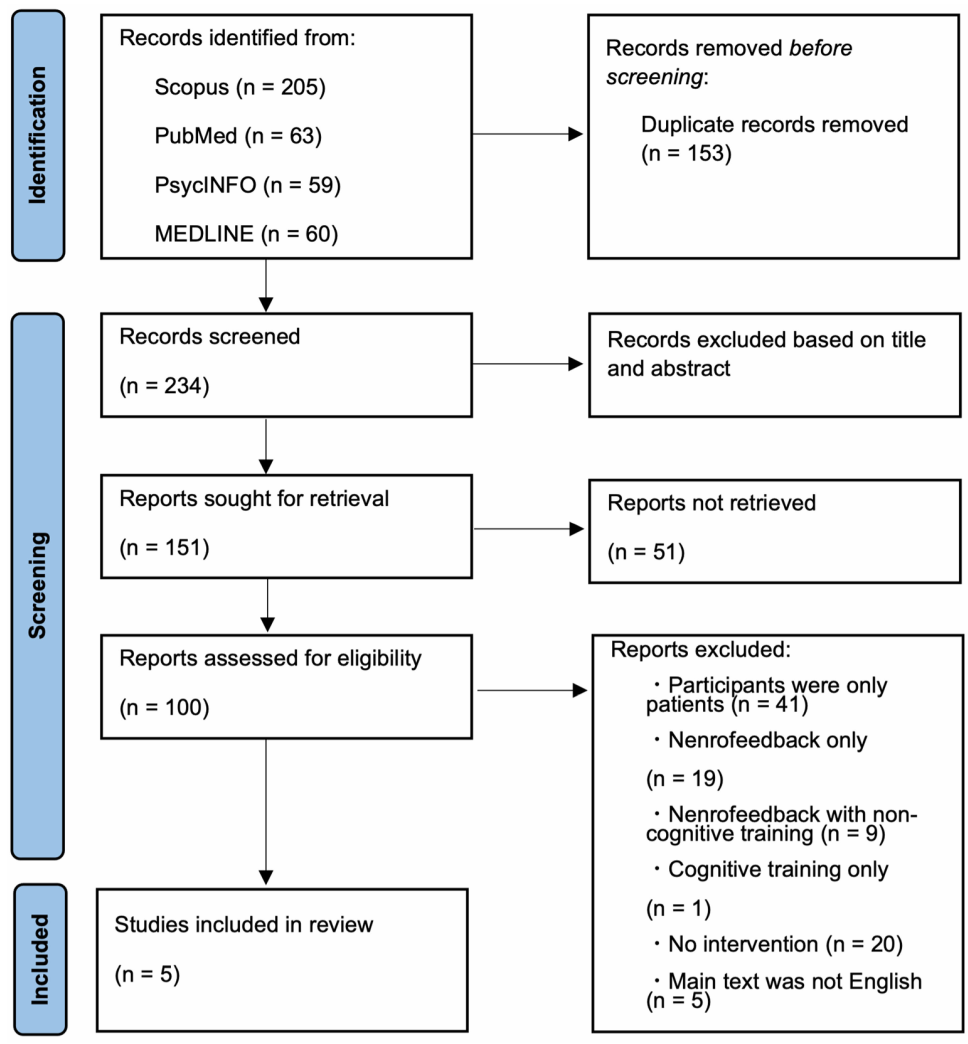
Figure 1. PRISMA flow